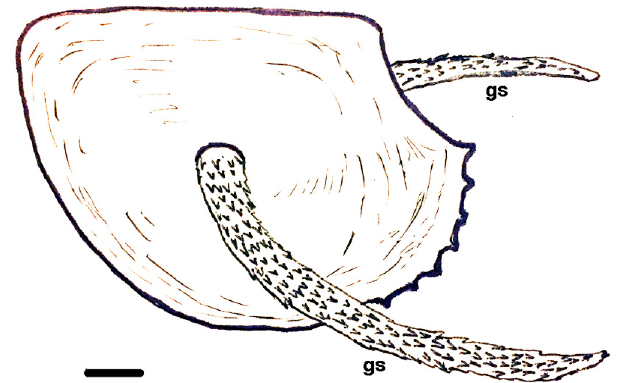
Figure 23. Mongolitubulus anthelios . Oblique side view, anterior to left. Scale bar 200 microns. Abbreviation: gs , great spine. Image Credit: Mark McMenamin.